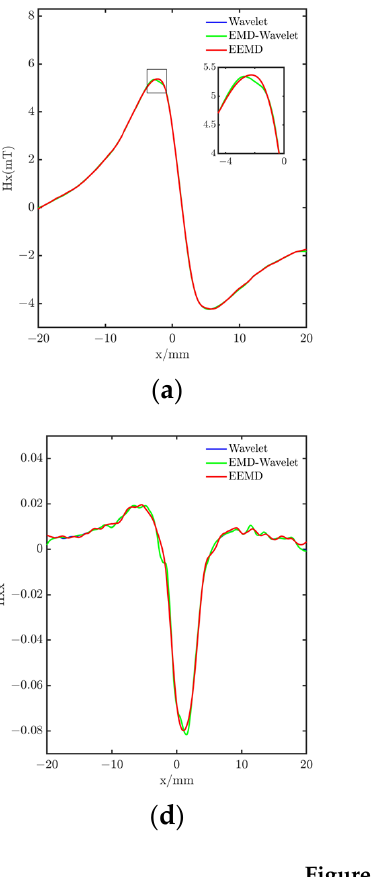
Figure 11. Comparison of three signal processing methods. ( a ) Comparison of normal component signals. ( b ) Comparison of tangential component signals. ( c ) Comparison of horizontal compo- nent signals. ( d ) Comparison of gradient values of normal component signal. ( e ) Comparison of gradient values of tangential component signal. ( f ) Comparison of gradient values of horizontal component